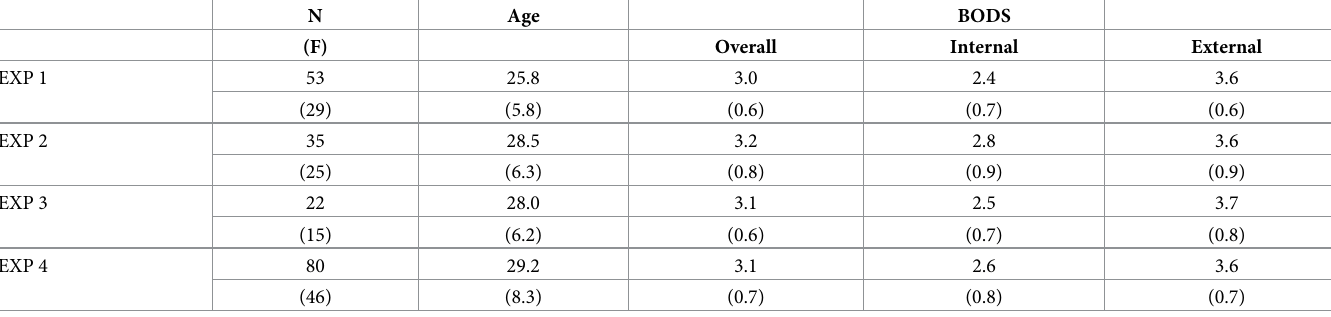
Table 1. Descriptive statistics and mean scores on the body odor disgust sensitivity (BODS) scale in each